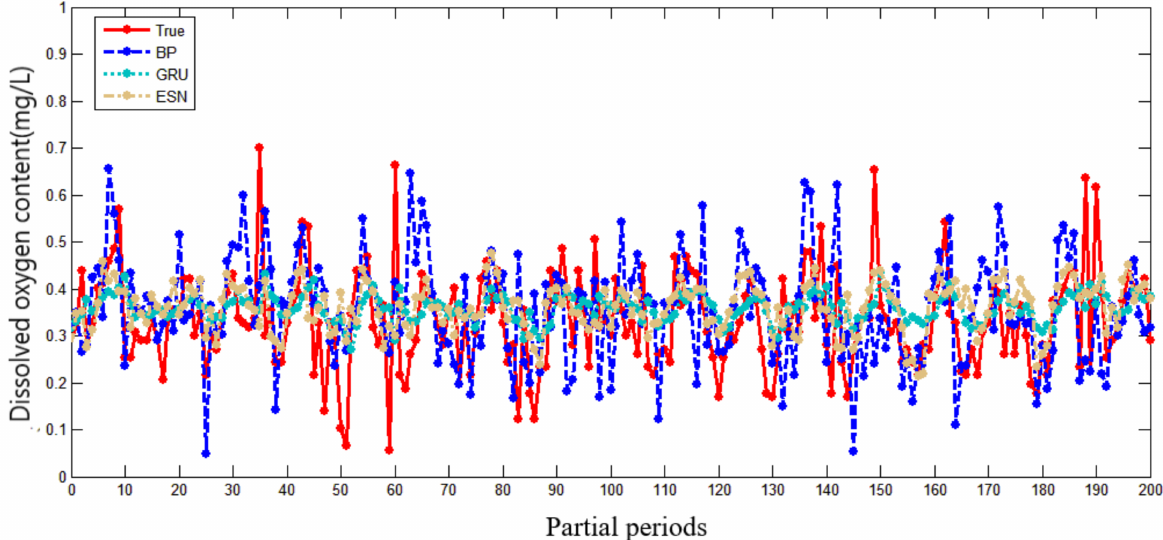
Figure 9. Partial prediction results of different prediction models in Western Buffer